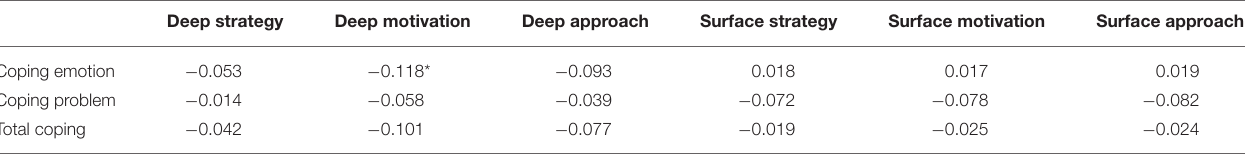
Table 5 | Relation between the variables of learning approach with coping strategies.